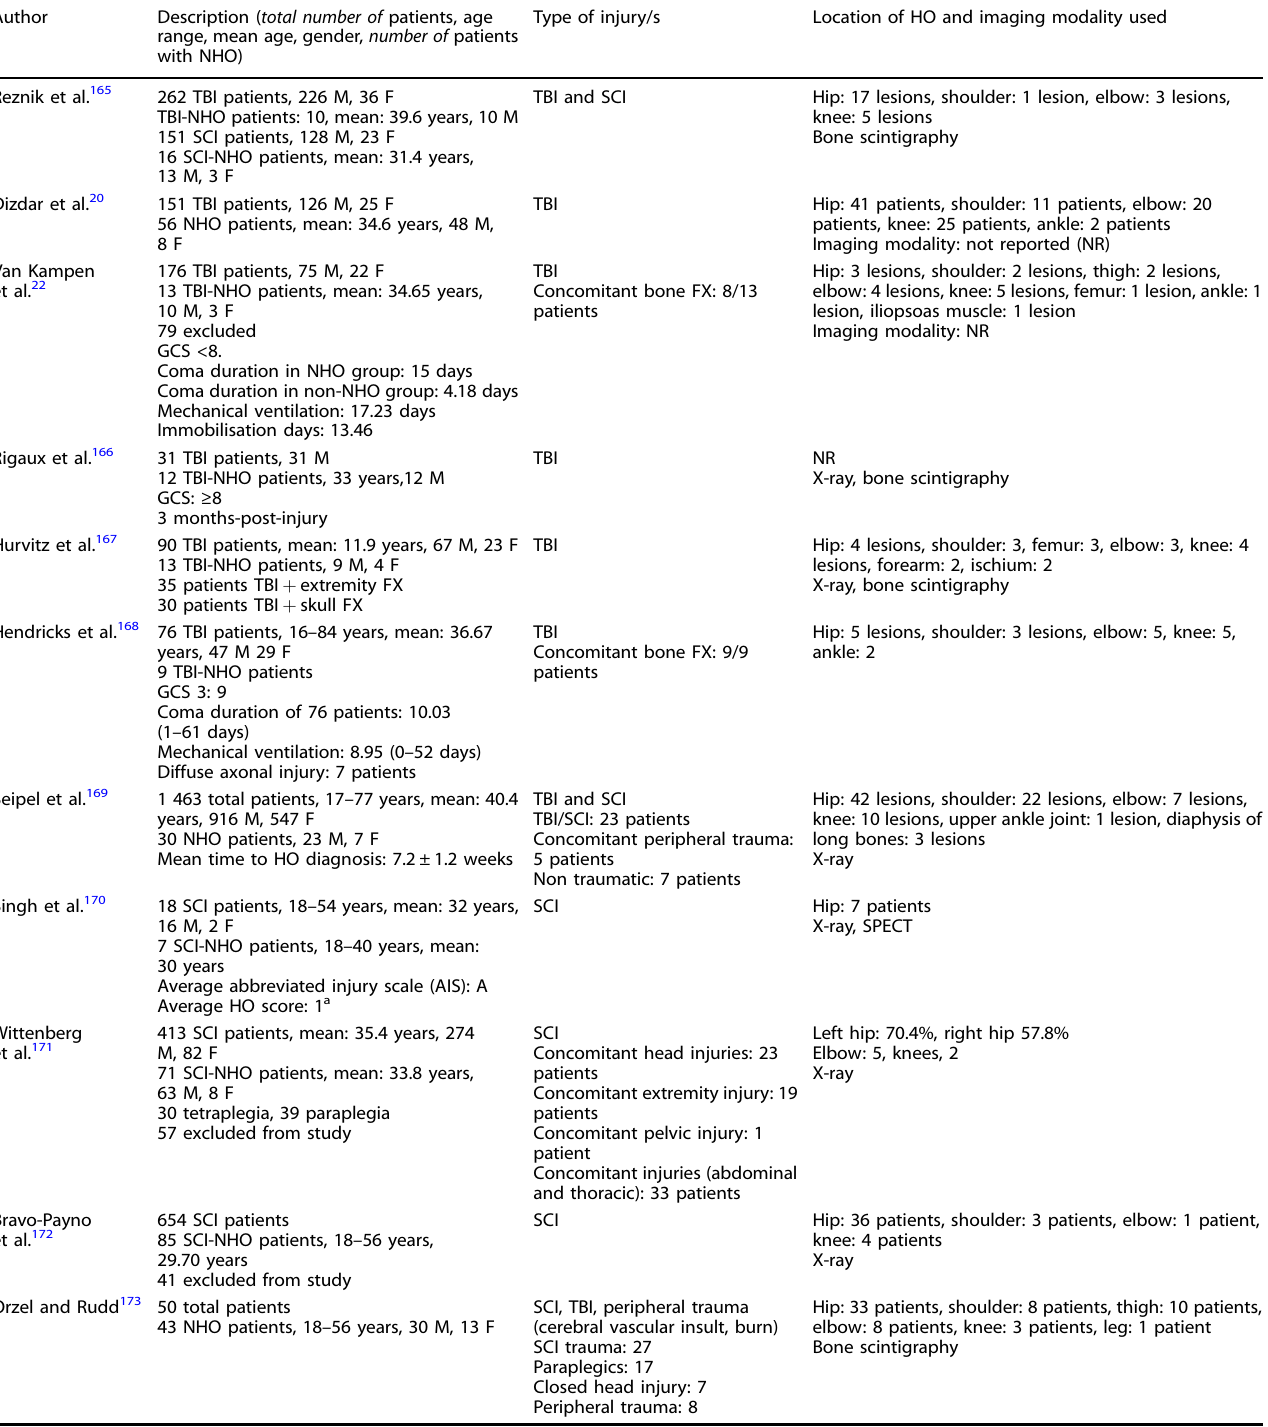
Location of HO and imaging modality